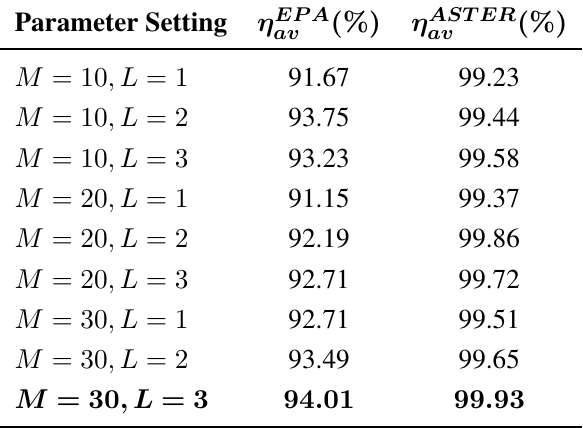
Table 2. Performance comparisons of the proposed method with different parameter